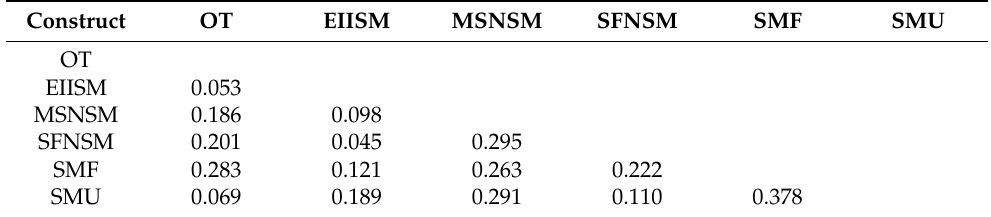
Table 4. Discriminant validity analyses